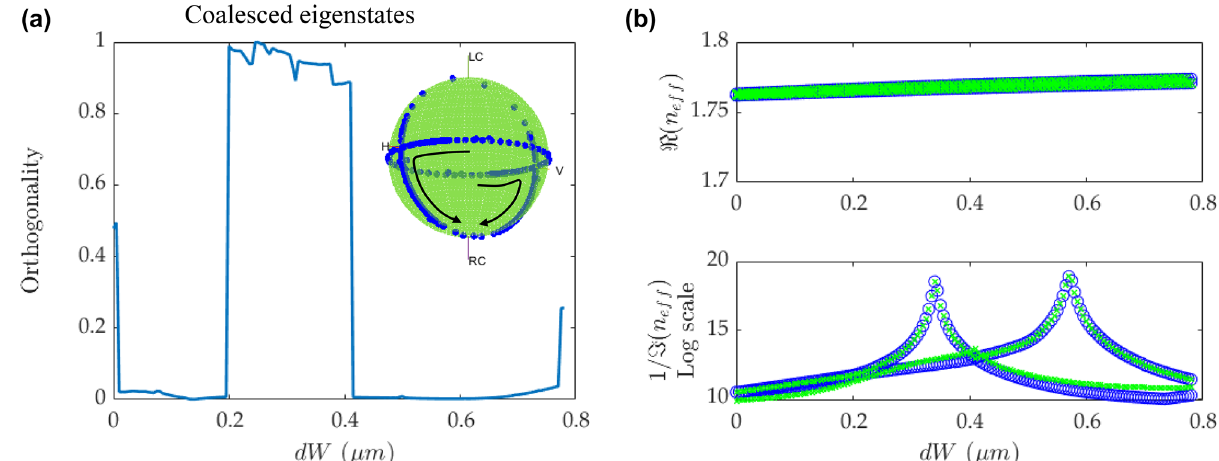
Figure 6: Transition between coalesced eigenstates and orthogonal eigenstates under extremely low-loss condition. (a) The orthogonality versus d W with C = 0.7. The inset shows the corresponding evolution of the eigenvectors on the Bloch sphere. The imaginary part is magnified by a factor of 10 4 for better visualization. The arrow shows the corresponding evolution of eigenstates on the Bloch sphere. versus d W (b) The real and imaginary parts of n eff